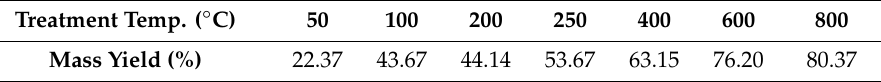
Table 2. Mass yields of carrot pulp after thermal treatment at di ff erent temperatures, 50 up to 800 ◦ C. The mass yield was obtained from the values provided by thermogravimetric analysis (TGA) software. Treatment Temp. ( ◦ Figure 3. Thermogravimetric analysis of carrot pulp stabilized and carbonized at temperatures between 50 and 800 °C.